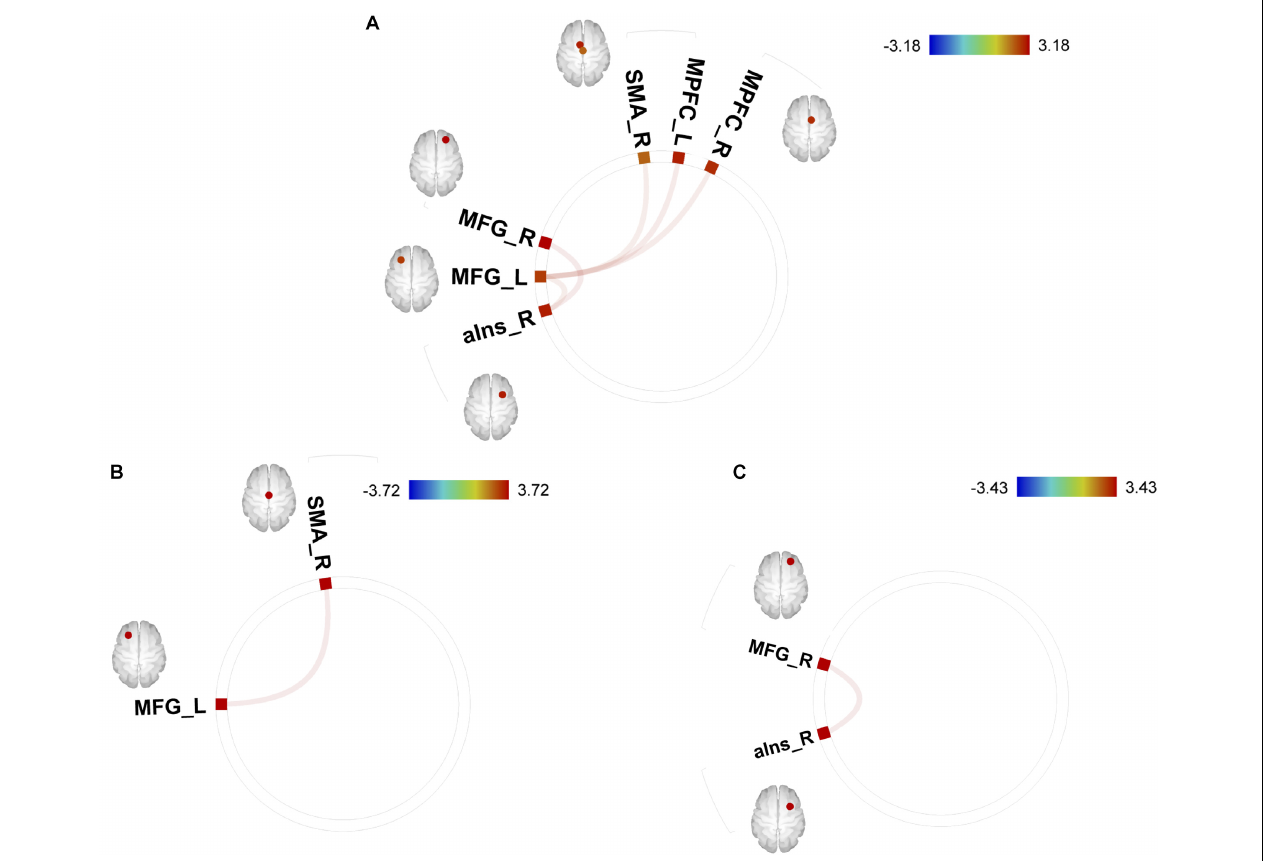
FIGURE 1 | Correlations between (A) GPIUS2 total scores/ (B) mood regulation subscale/ (C) deficient self-regulation and functional connectivity values among motivation network. MFG, middle frontal gyrus; SMA, supplementary motor area; aIns, anterior insula; MPFC, medial prefrontal cortex; L, left; R, right; ROIs_Motivation. Mo, regions of interest within motivation network.